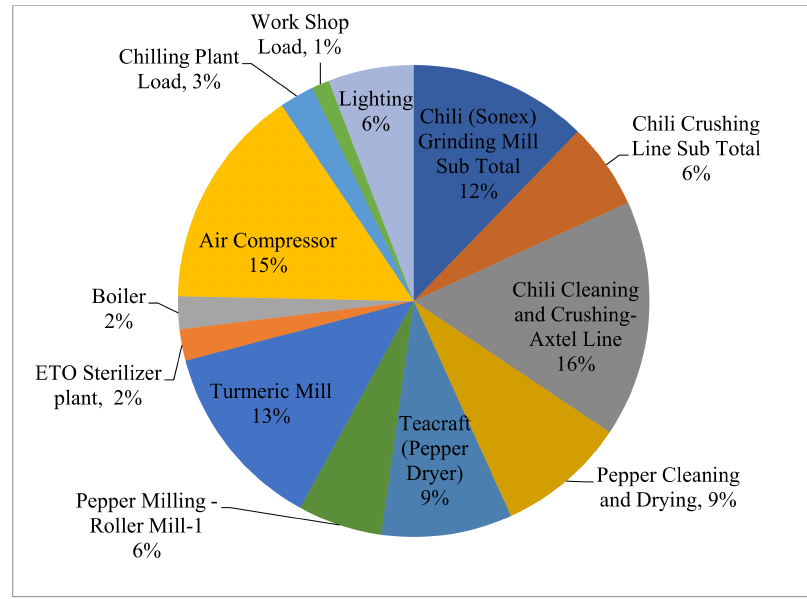
Figure 1. Electrical load sharing of the